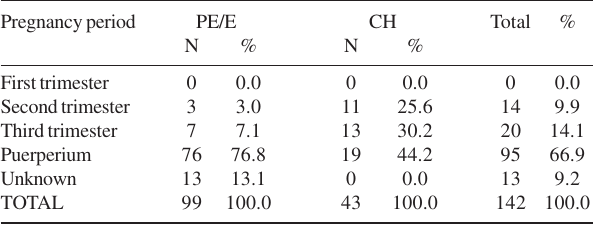
Table 2 - Distribution of the 99 cases of maternal death due to preeclampsia/eclampsia (PE/E) and of the 43 cases resulting from disorders in pregnancy of chronic hyper- tension (CH) according to time of death during pregnancy and puerperium (São Paulo City,